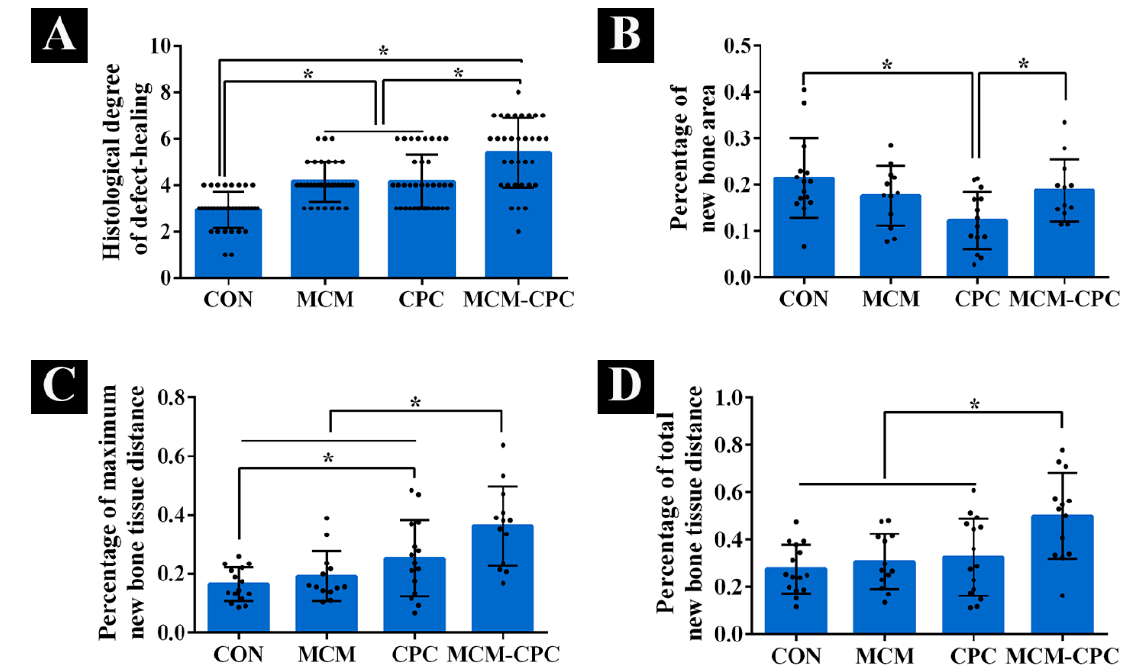
Figure 7. Histomorphometric analysis of new bone formation. ( A ) histological evaluation of the degree of defect healing according to Huo et al. [19] based on hematoxylin and eosin and Masson–Goldner-trichome stained sections, ( B ) percentage of new bone formation area related to the initial defect area, ( C ) percentage of maximum distance of new bone to the initial defect length, ( D ) percentage of total distance of new bone to the initial defect length (mean ± SD, * p < 0.05).